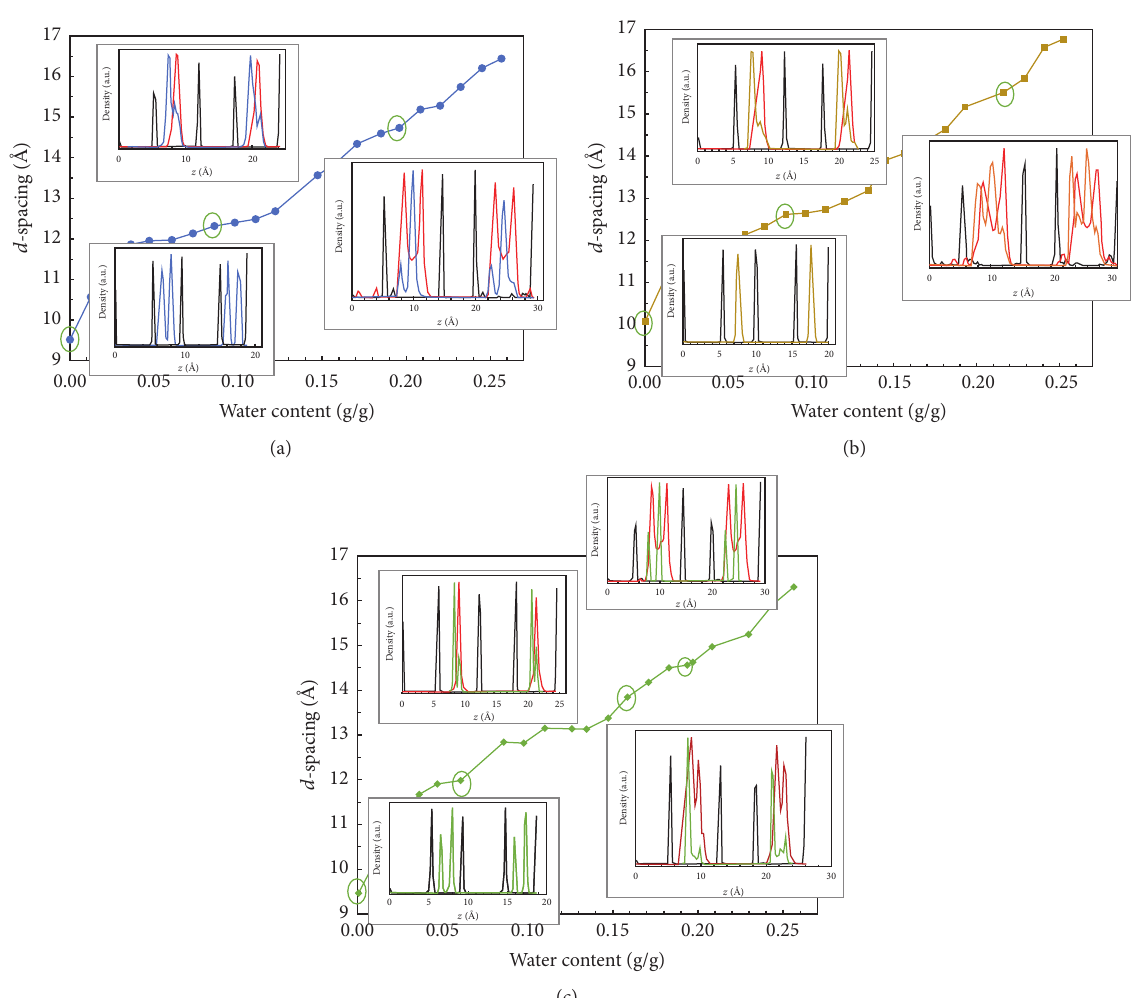
Figure 5: Swelling curves and density profiles for Na- (a), K- (b), and Ca-montmorillonite (c) as a function of water content from MD simulations at 1atm and 300 K. Color code: black: clay surface; red: water oxygen; blue: sodium; ochre: potassium; green: